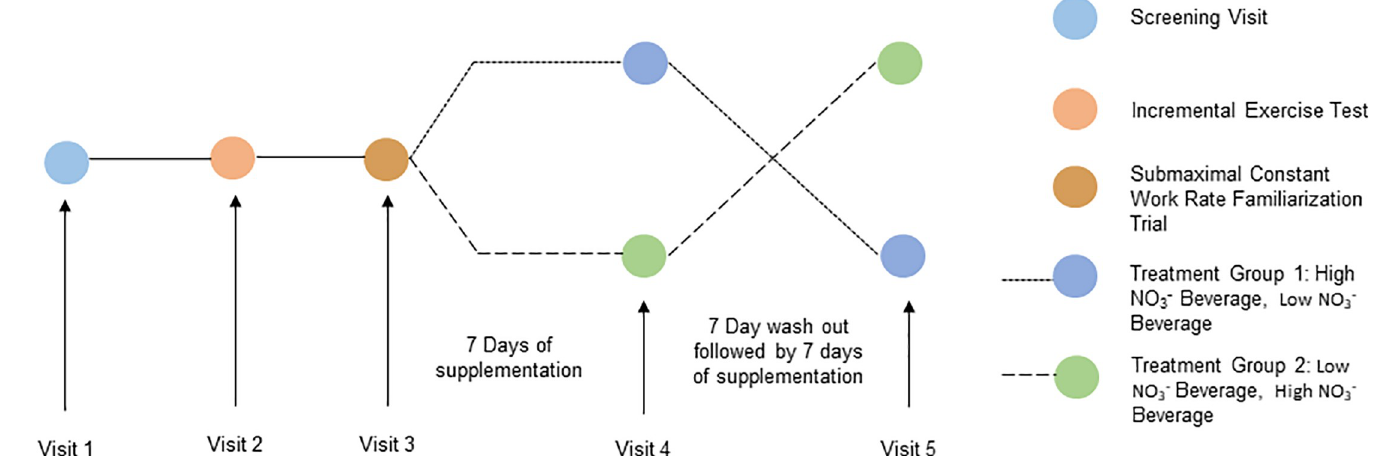
was obtained to determine baseline plasma NO 3- and NO 2- levels. Subjects then consumed two servings (4 ounces) of a NO 3- rich dietary supplement (AMPED NOx; Isagenix International, LLC, Gilbert, AZ, USA) containing 9.9 mmoles of NO 3- . Approximately two hours later, a sec- ond 3–4 ml venous sample was obtained for the determination of plasma NO 3- and NO 2-